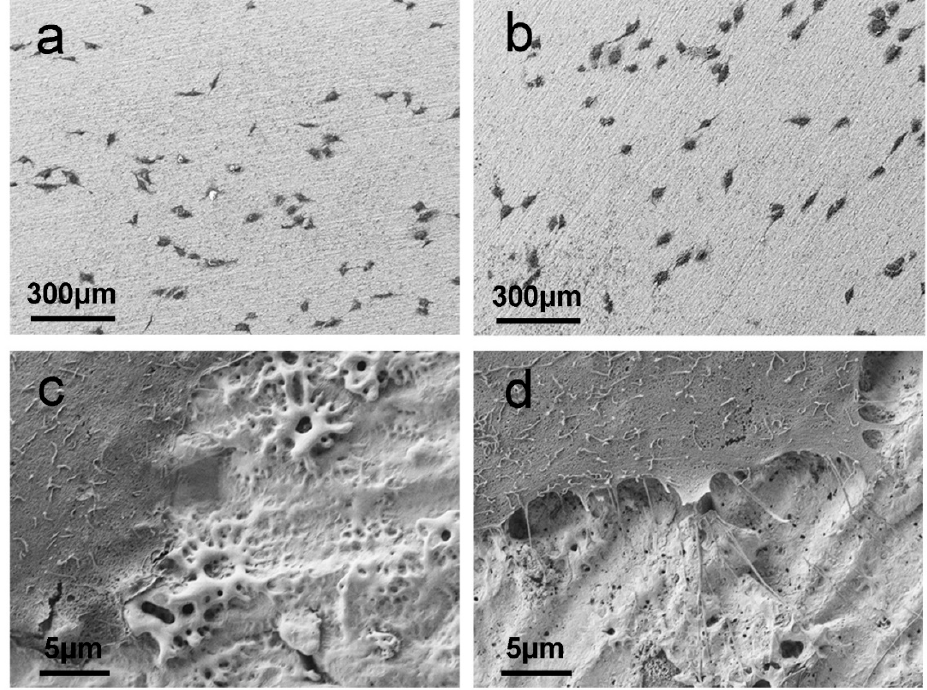
Figure 5. SEM images at ( a , b ) low and ( c , d ) high magnification of MG-63 osteosarcoma cells after 48 h incubation on ( a , c ) Nb200V and ( b , d ) Nb200V + etching.